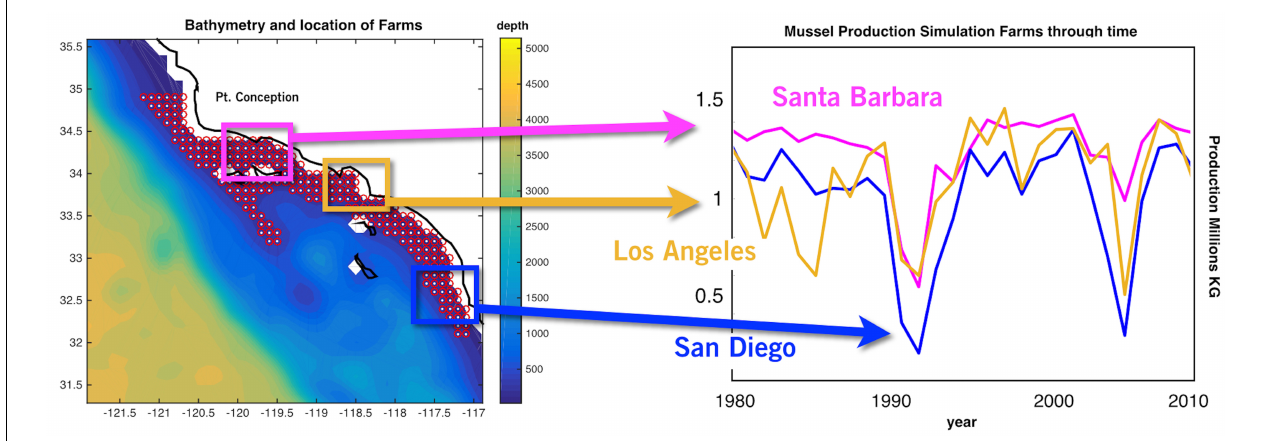
FIGURE 1 | (Left) Coastal region of the Southern California Bight where environmental forcing was considered. The region was subdivided in 223 sites or locations (red circles). (Right) Production time series of 3 representative sites of the three main regions in the SCB, for the 1981–2008 period, as an example of variability in production year by year. Each production is calculated on an annual time step and is considering the time of